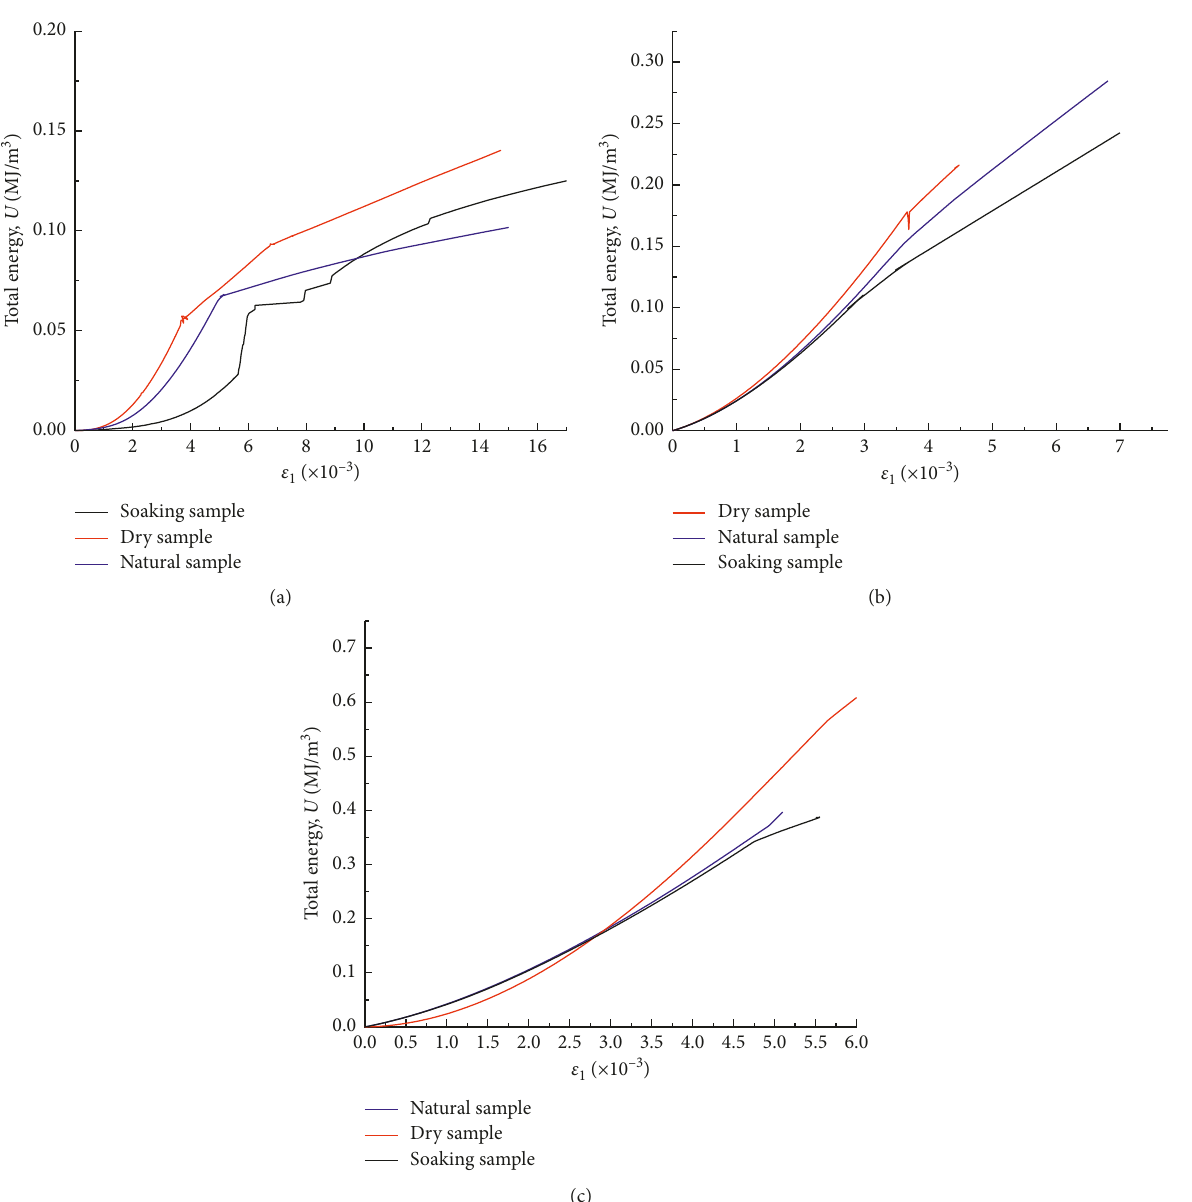
Figure 5: Relation curves of total energy with strain under different confining pressures. (a) 0MPa. (b) 15MPa. (c)